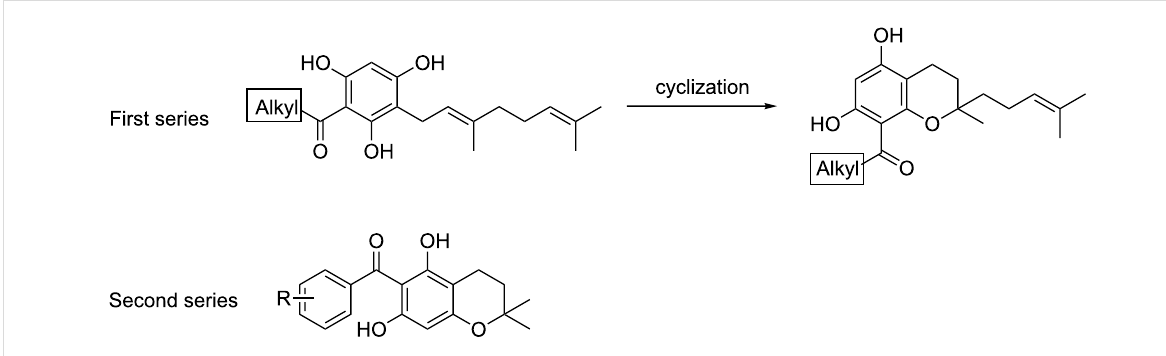
Figure 6: Structures of two series of natural-like acylphloroglucinols.